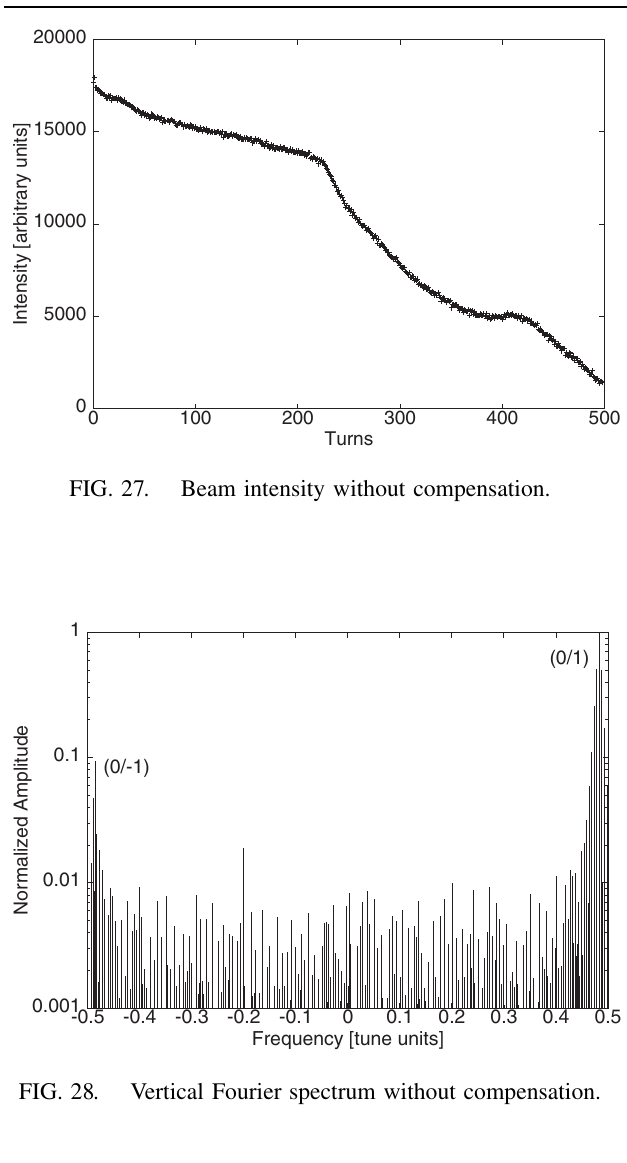
FIG. 30. Horizontal Fourier spectrum for bare machine.